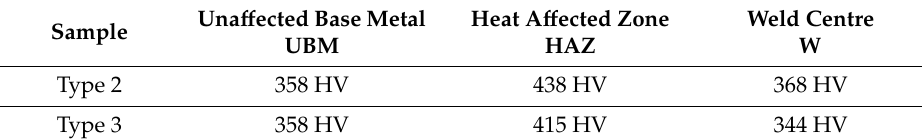
Table 4. Vickers hardness values of titanium welded samples at various locations [5].